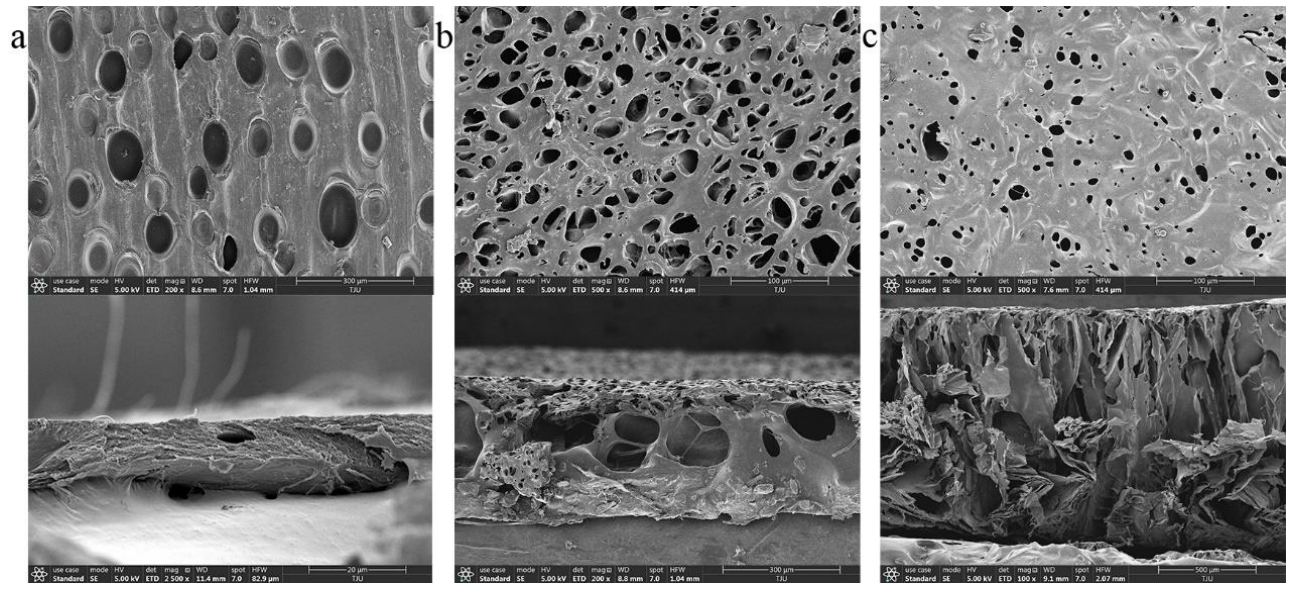
Figure 3. Images of chitosan discs using a scanning electron microscope (SEM). ( a ) SEM image of chitosan disc A, left for 2 h for dry phase separation. ( b ) SEM image of chitosan disc B, left for 1 h for dry phase separation. ( c ) SEM image of chitosan disc C, left for 0.5 h for dry phase separation.